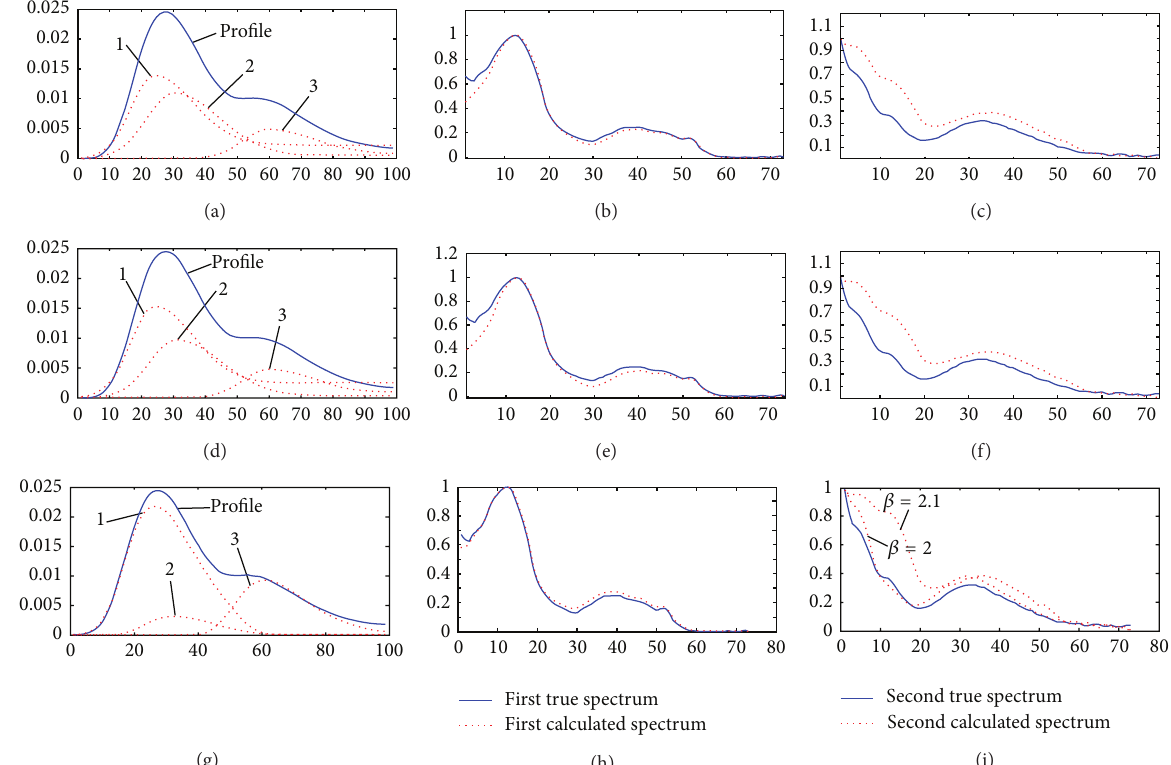
Figure 6: The calculated results. (a), (b), and (c) are for the GRCM-PSO method. (d), (e), and (f) are for the ICARCmPSO method. (g), (h), and (i) are for the MCR-ALS method. (a), (d), and (g) are the calculated chromatogram peaks. (b), (e), and (h) are the compares between first spectrum and corresponding calculated spectrum. (c), (f), and (i) are the compares between the second ones.